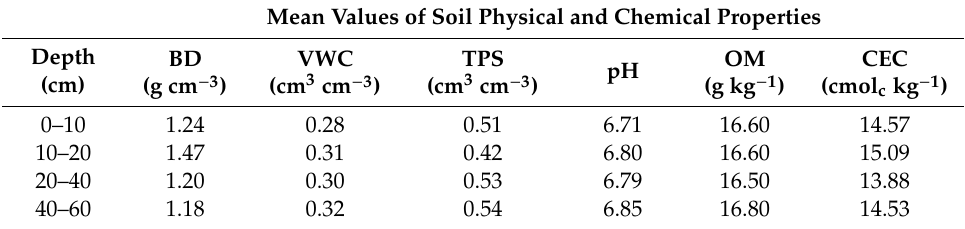
Table 1. Baseline soil physical and chemical properties at the study